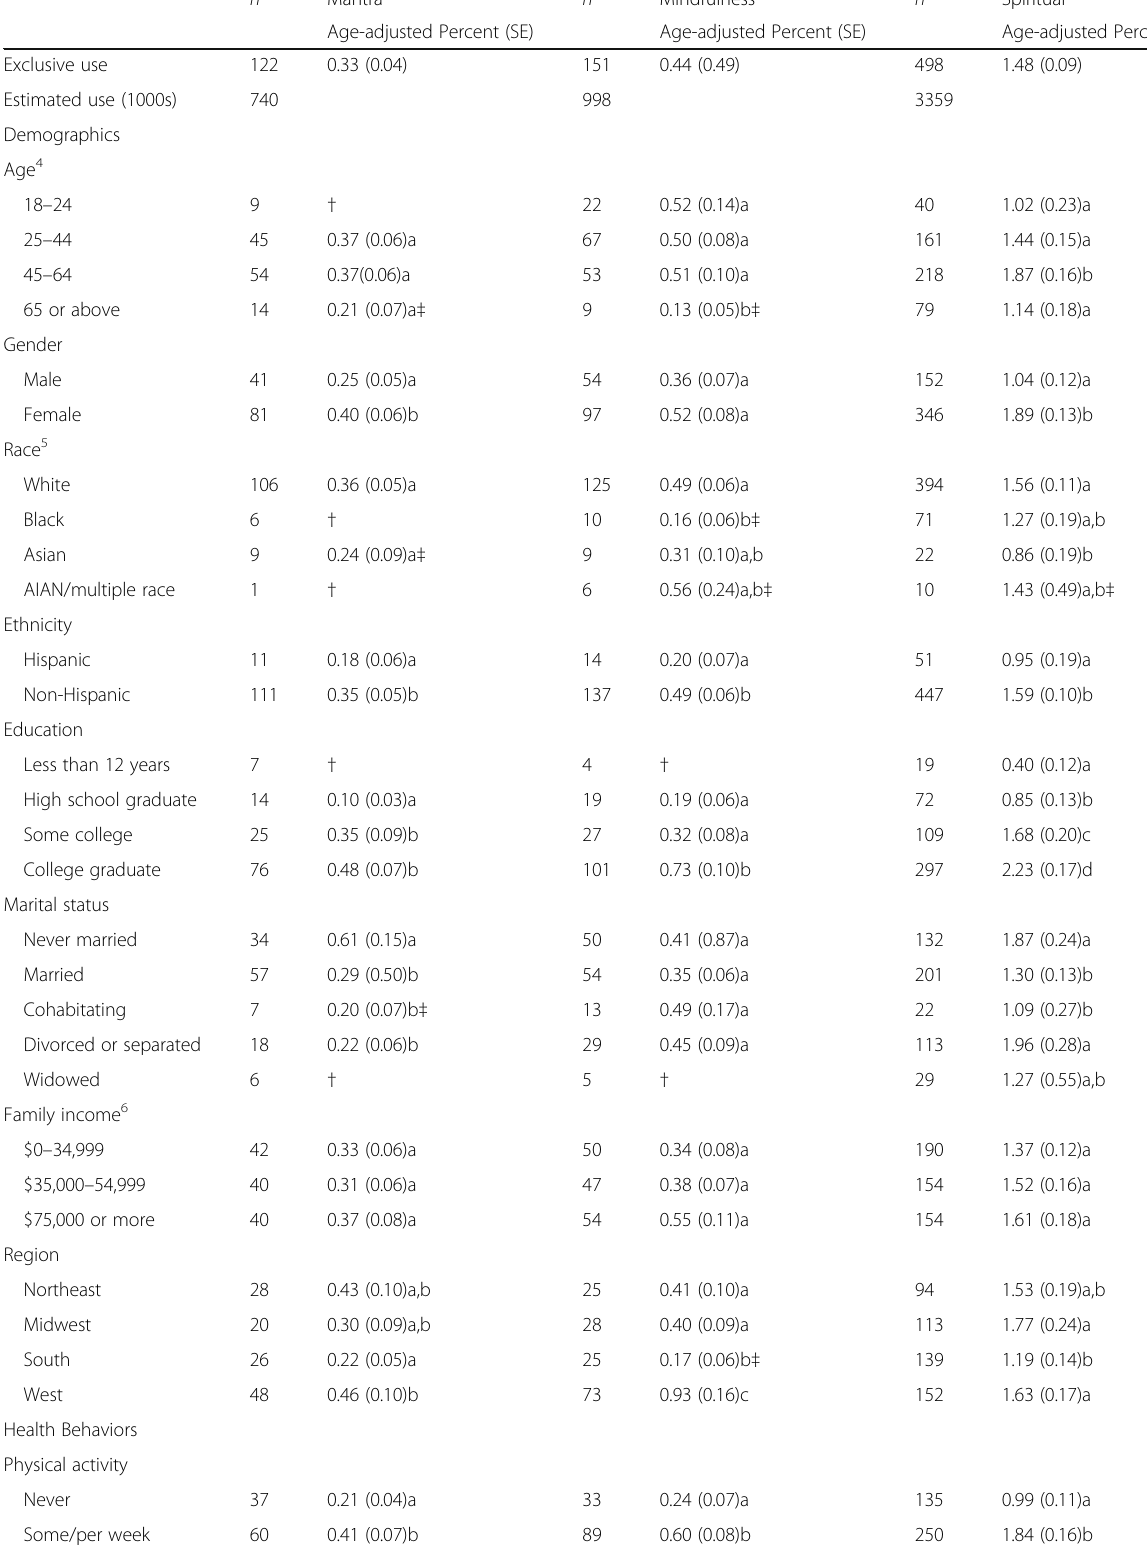
Table 2 Prevalence of meditation use by select user characteristics, exclusive use of one practice during previous 12 months 1 n 3 Mantra n